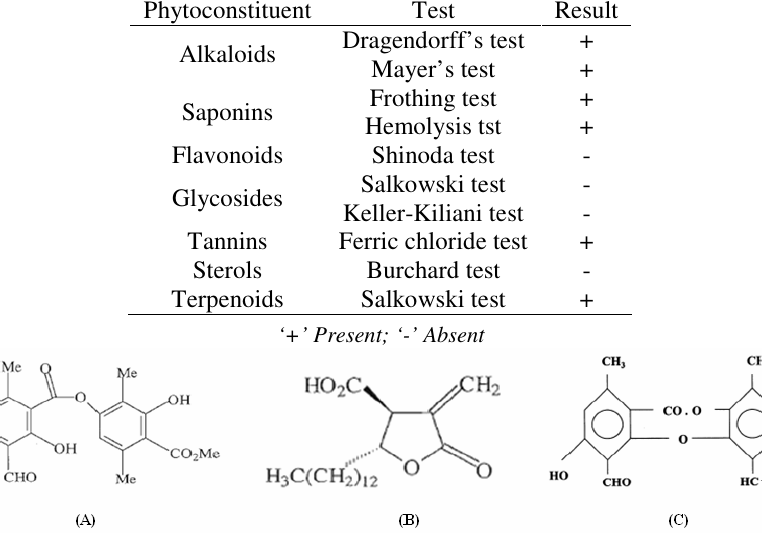
Figure 1. Structure of (A) Atranorin (B) Protolichesterinic acid and (C) Salanizic acid